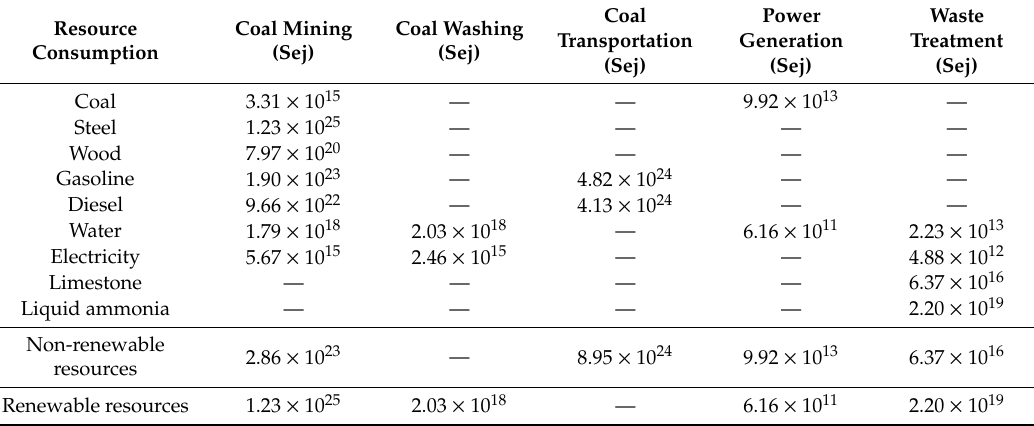
Table 7. Life cycle resource consumption of Unit